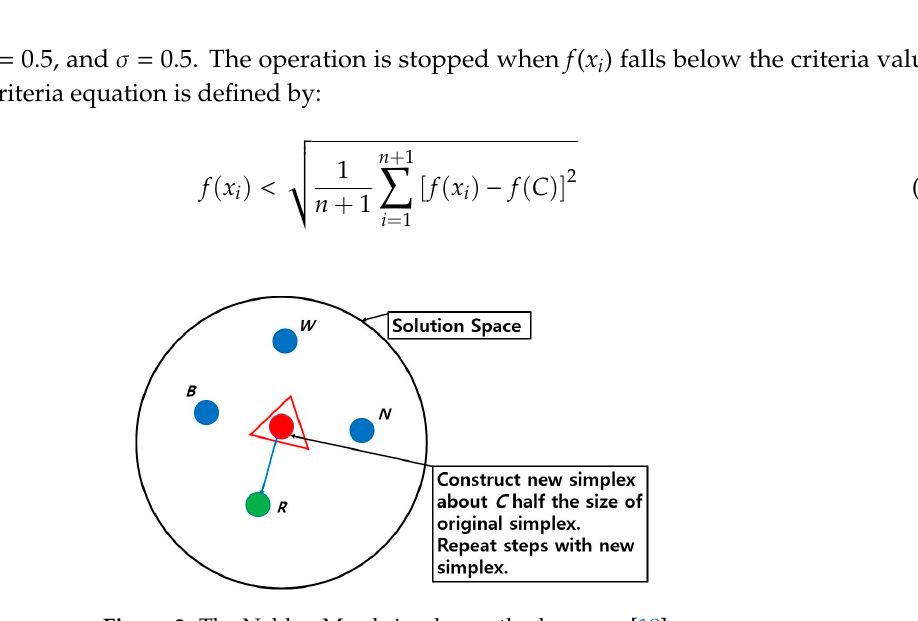
Figure 2. The Nelder–Mead simplex method process [18] .